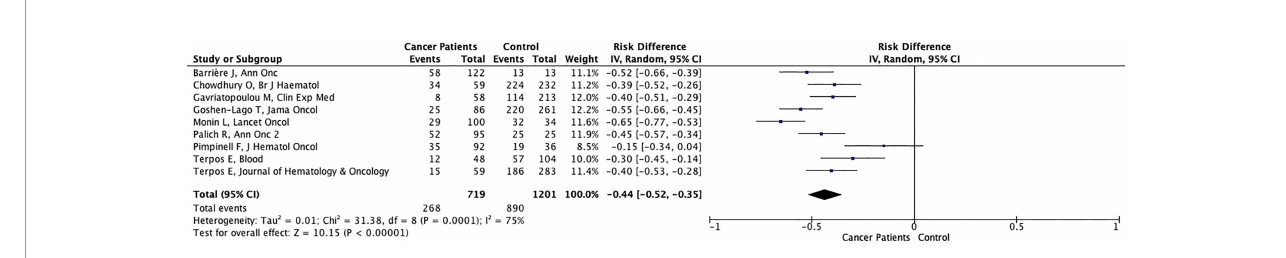
FIGURE 3 | Forest plot illustrating the risk differences of seroconversion rates between cancer patients and healthy controls with fi rst dose of vaccination.